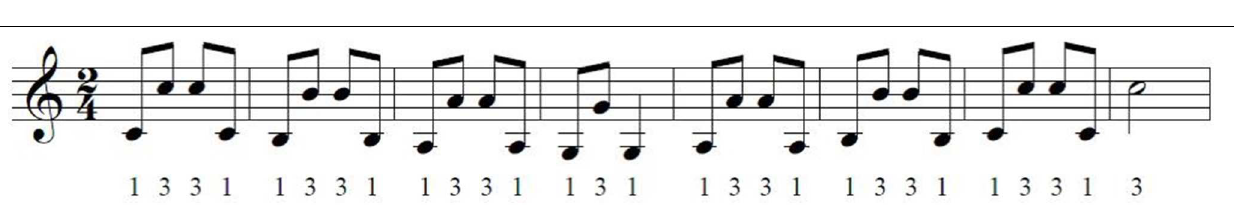
TABLE 1 | Mean Vp/d of the four levels of emotion (A, anger; F, fear; H, happiness; S, sadness) and the four levels of fingerings (SW, small-weak; SS, small-strong; LW, large-weak; LS, large-strong).